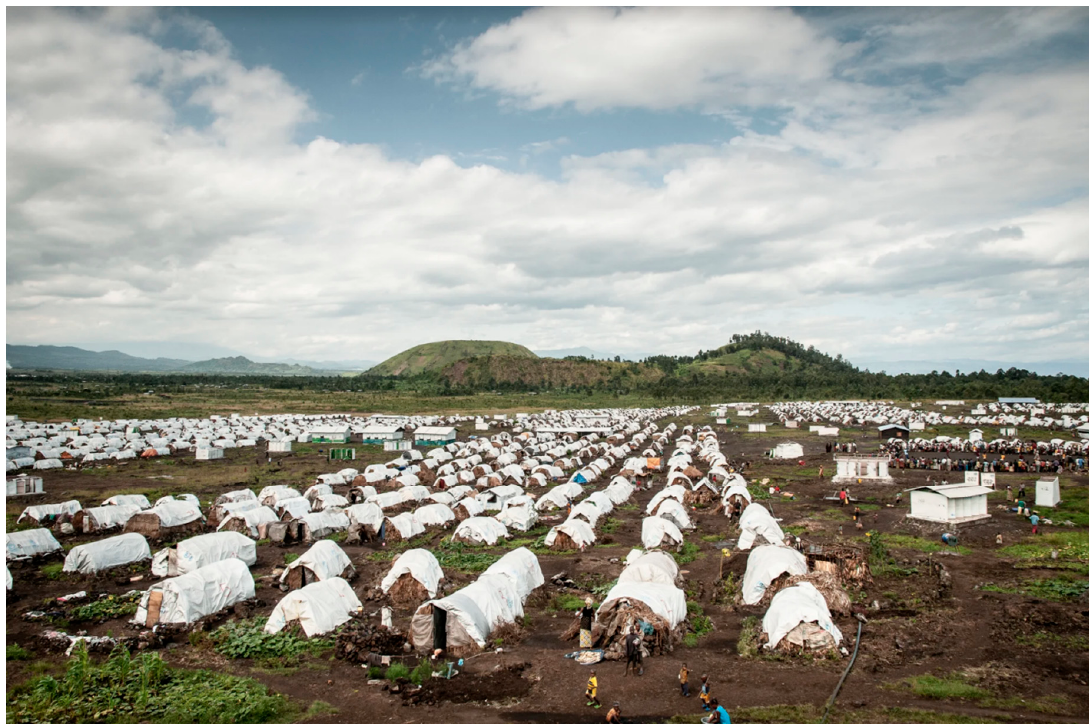
Figure 3. Hundreds of thousands of people have been forced to flee their homes to escape violent conflict in the Democratic Republic of Congo. Many ended up living in displacement camps like this one outside the city of Goma in the Congo. Photo by Colin Crowley.